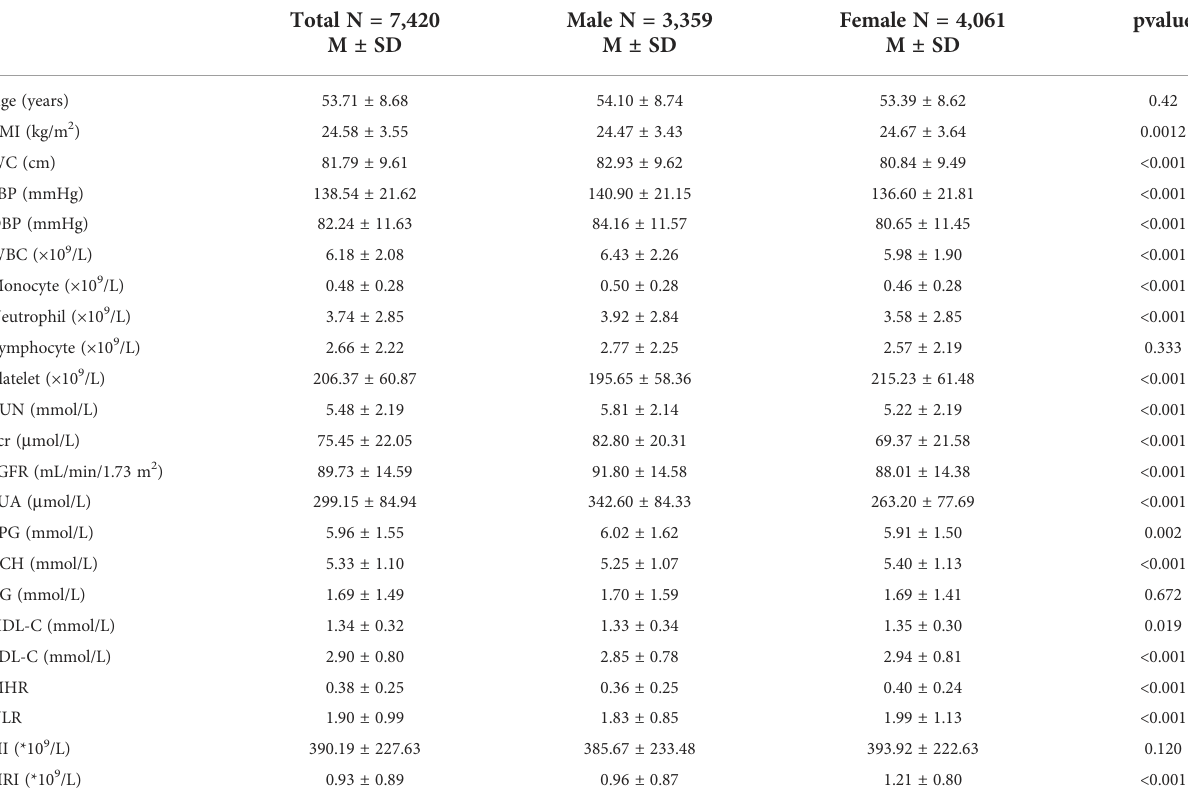
TABLE 2 The anthropometric and biochemical parameters of the baseline